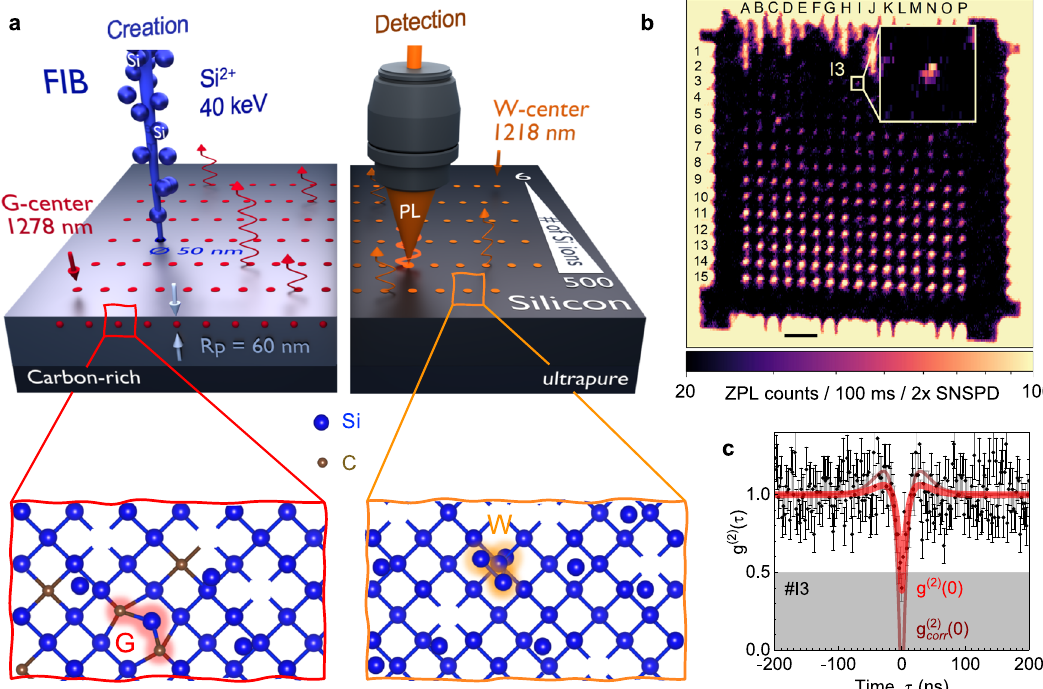
Fig. 1 | Creationand detectionof single G and W centers in silicon. a Schematic of FIB implantation with Si 2+ ions and PLcollection from singlecenters. Thekinetic energy of 40keV corresponds to an average implantation depth R p =60nm. Si implantation into a carbon-rich and an ultrapure silicon wafer results in the for- mation of the G and W centers, respectively. b Confocal ZPL (1278nm) intensity map of locally created G centers on an SOI wafer. The number of ions per spot increases logarithmically from nominally 6 (row 1) to 570 (row 15). The pattern